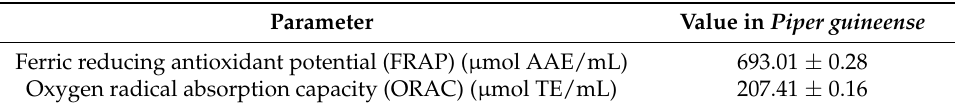
Table 1. The antioxidant capacity of Piper guineense methanol extract.